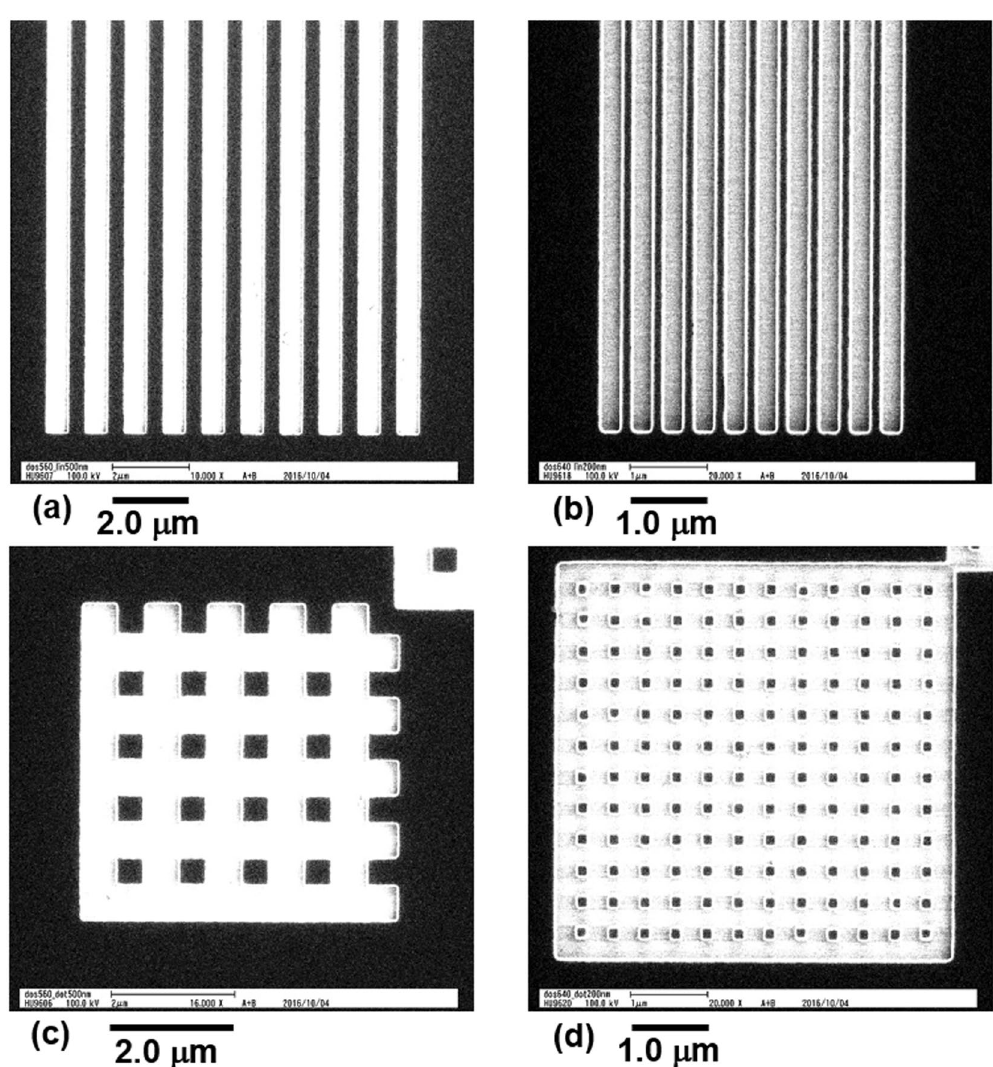
Figure 4. Plan-view SEM micrographs of line and space and square patterns for ZEP520a containing PCBM. The mask patterns of the lines and spaces have a line width of ( a ) 500 nm and ( b ) 200 nm, and the square mask patterns have a side length of ( c ) 500 nm and ( d ) 200 nm. Area doses are 560 μ Ccm − 2 in ( a ) and ( c ) and 640 μ Ccm − 2 in ( b ) and ( d